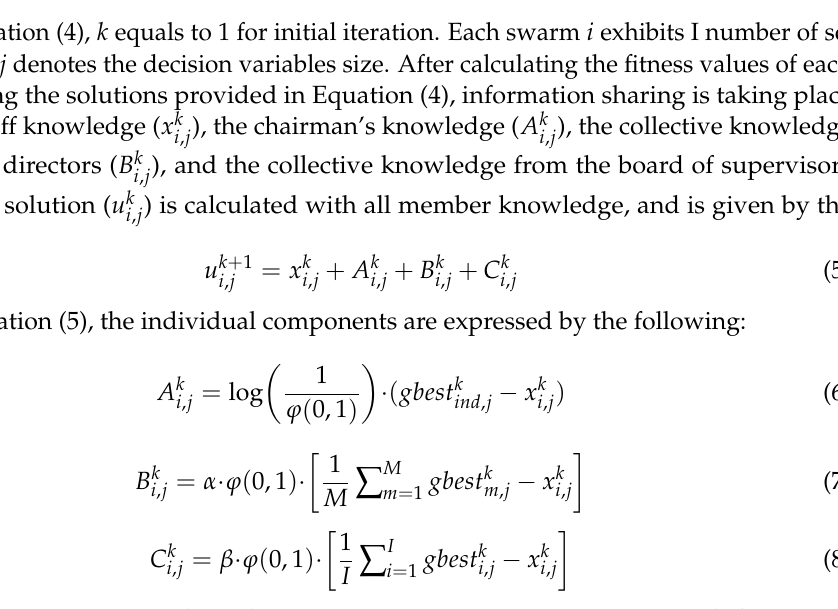
Figure 1. Architecture of ELM-CSO model.